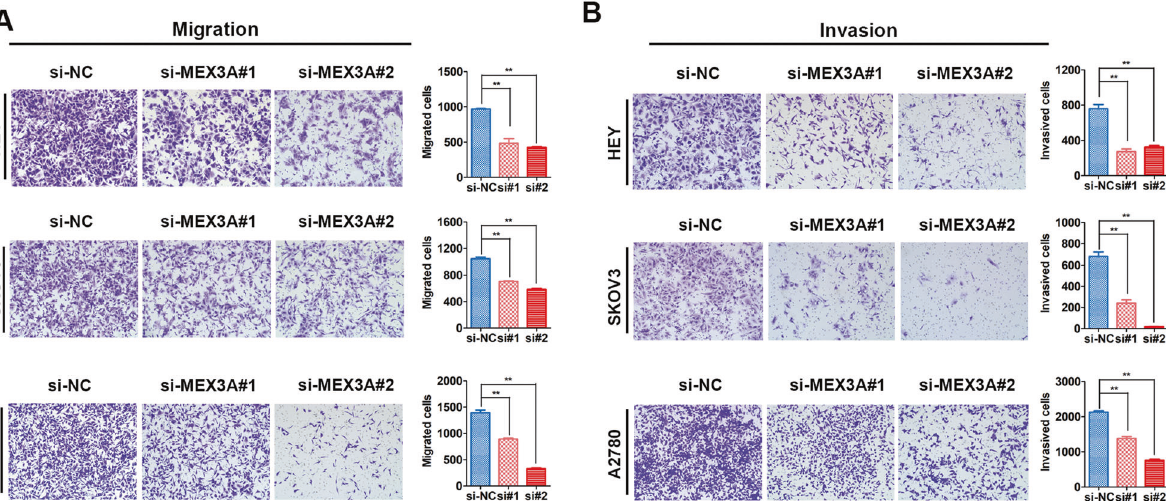
Fig. 3 MEX3A downregulating suppresses the metastasis of ovarian cancer cells. A Transwell assays were used to evaluate the effect of MEX3A expression on the migration of ovarian cancer cells ( n = 5 biologically independent samples). B Transwell assays were used to evaluate the effect of MEX3A expression on the invasion of ovarian cancer cells ( n = 5 biologically independent samples). P -value was obtained by unpaired t -test. Results represent the mean ± SD of three independent experiments. * P < 0.05, ** P <